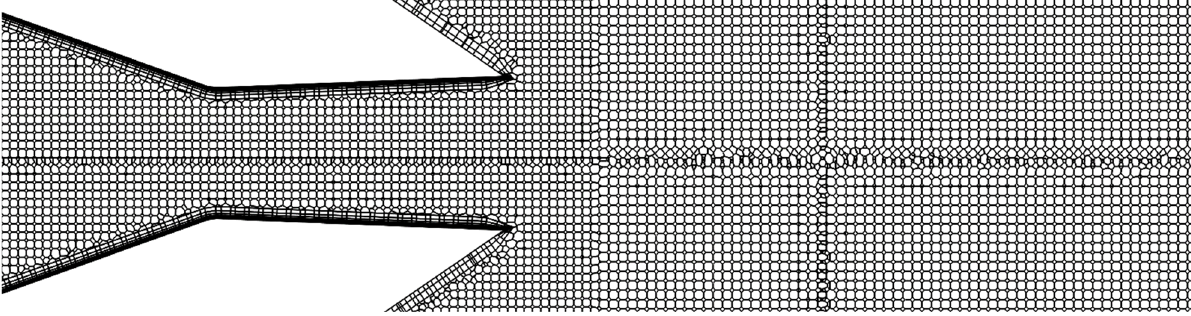
Figure 3. Fine RANS mesh.